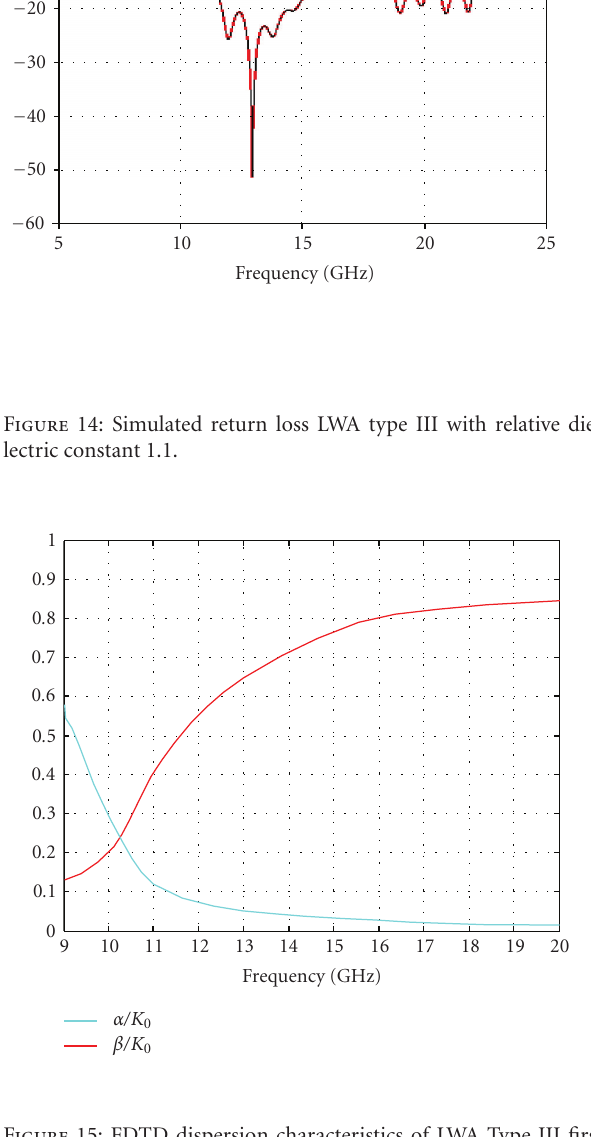
Figure 13: The measured and simulated radiation patterns of E field of half tapered LWA (at 8GHz).